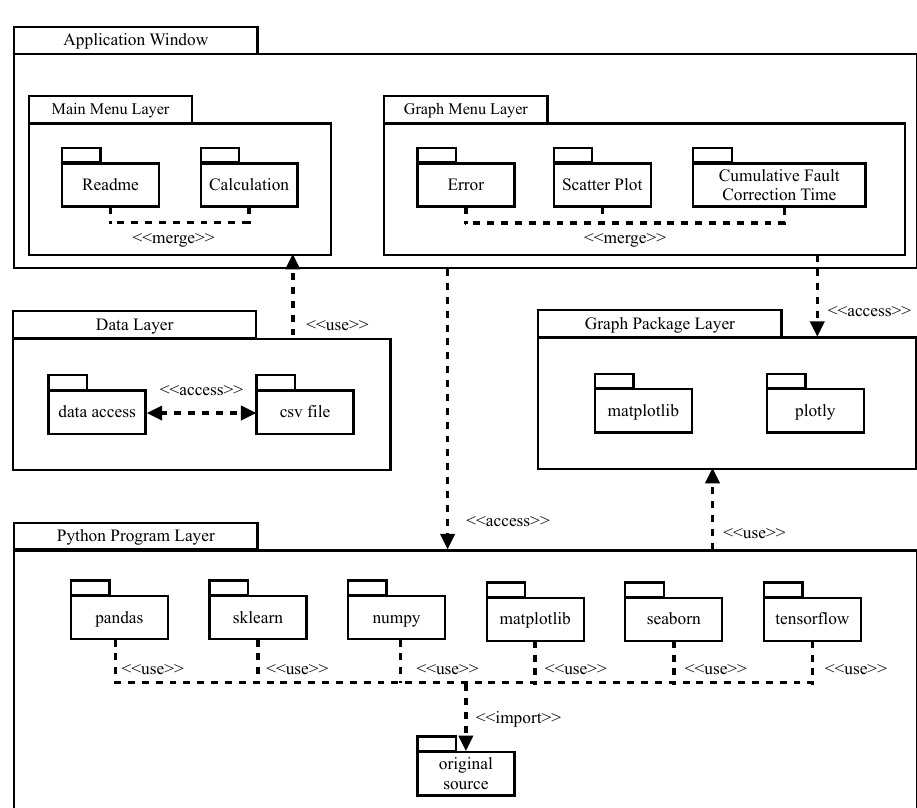
Figure 4. The package diagram of the prototype developed by using UML.